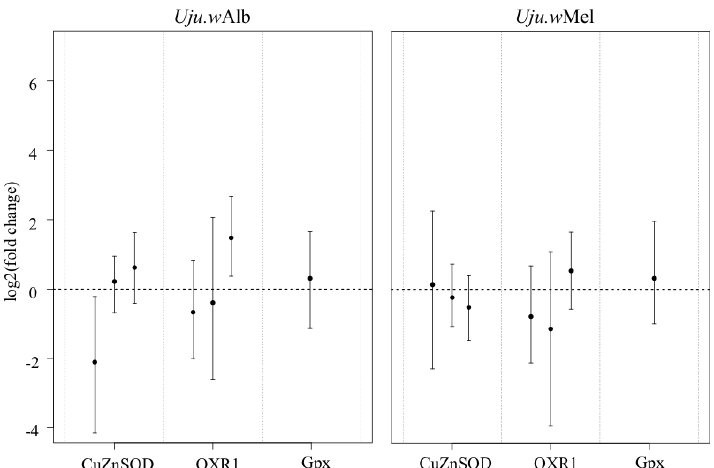
Figure 6. Transcription of CuZnSOD, Gpx and OXR1 in Uju. w Alb and Uju. w Mel adult females, normalised to S17 transcription and to uninfected Uju.T. Points represent mean of 3–5 pools of three females and error bars denote Bayesian 95% credible intervals. Each bar within a gene category represents an independent experiment.